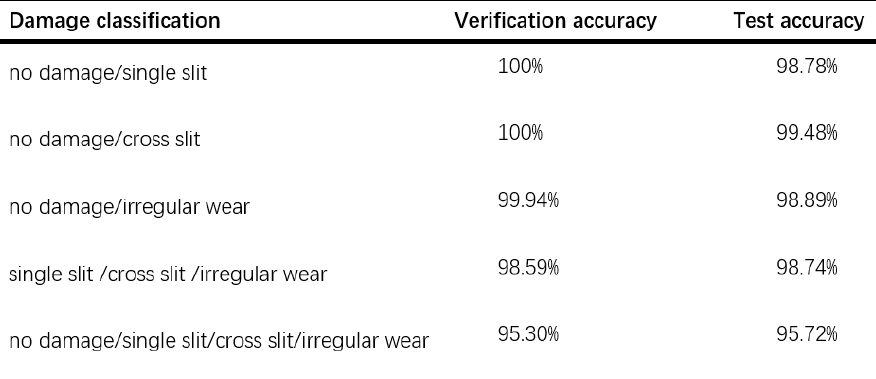
Table 2. Diagnosis accuracy under different